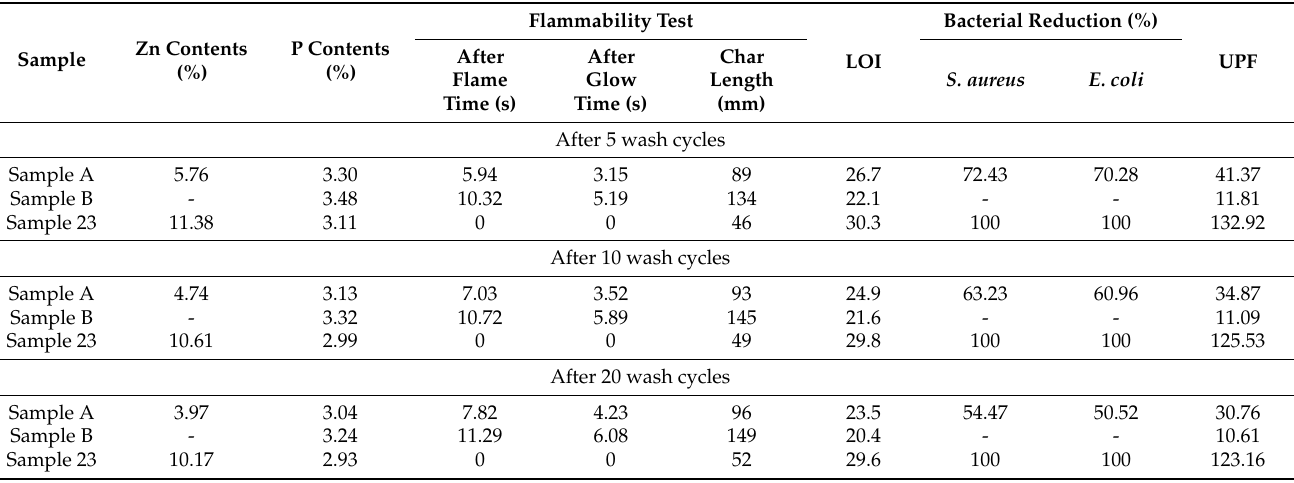
Table 9. Results of Zn contents, P contents, flammability test, LOI, bacterial reduction, and UPF after different wash